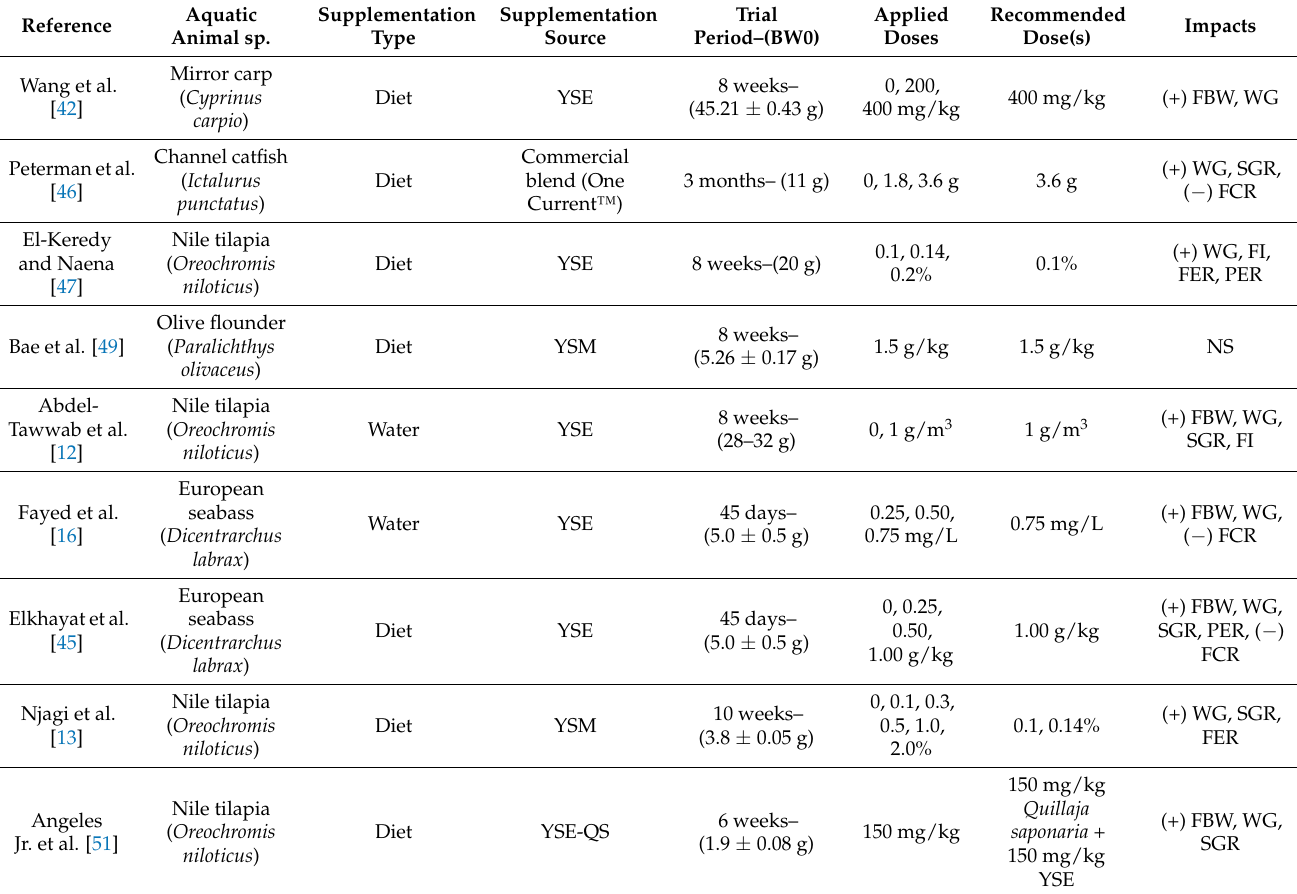
Table 1. Yucca schidigera /saponin effects on the growth performance and feed utilization of aquatic species. Aquatic Reference Animal